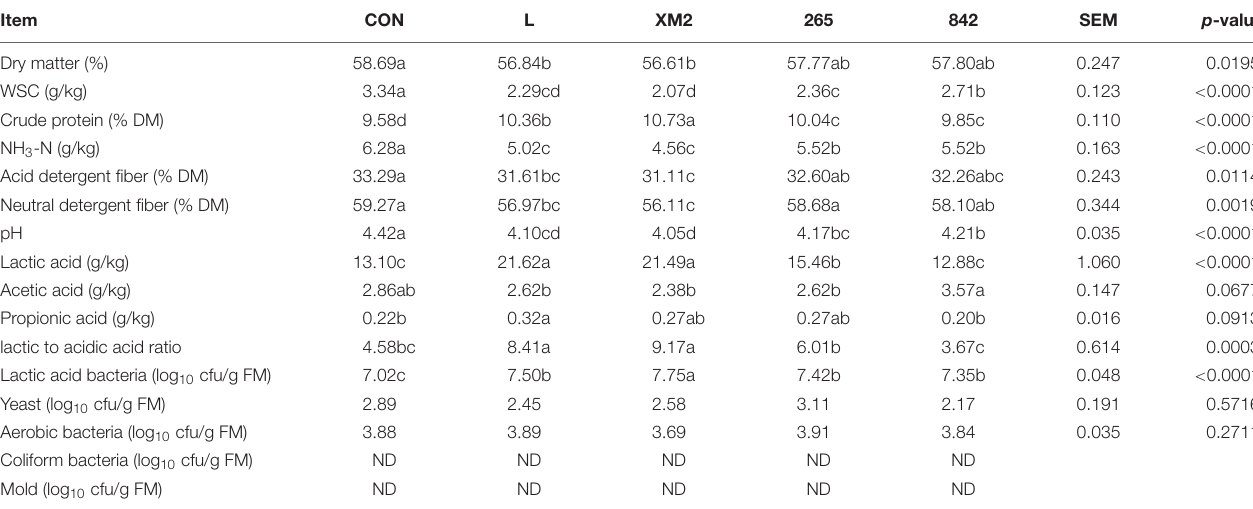
TABLE 5 | Chemical compositions, fermentation characteristics, and microbial populations on 30 days of ensiling.